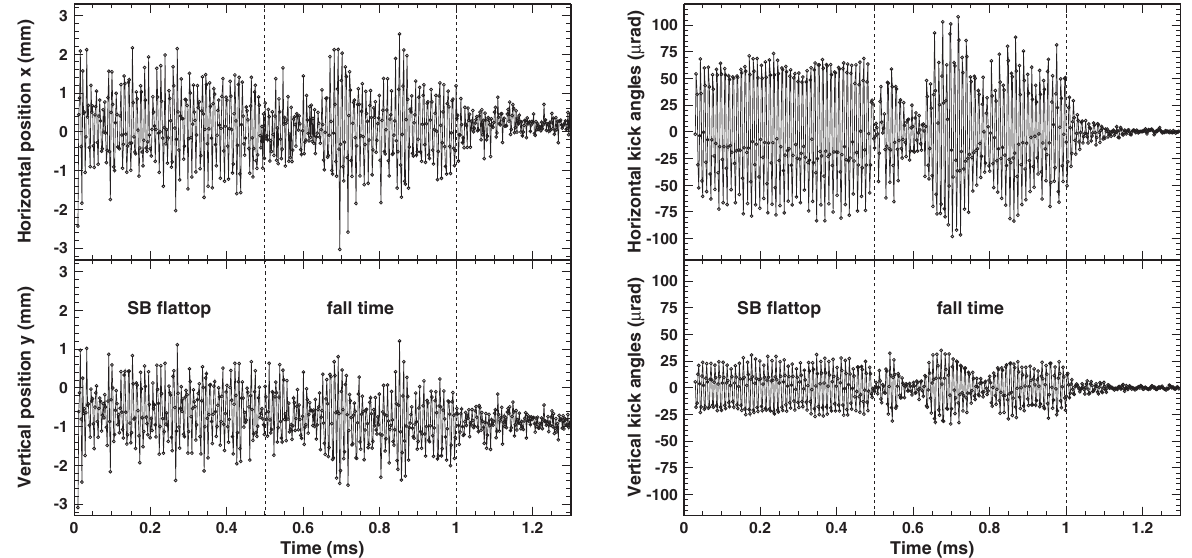
FIG. 16. (Left) Turn-by-turn coherent position oscillations for the first 1.3 ms measured with BPM. (Right) Kick angles of the dipole field ripple evaluated from the turn-by-turn BPM data.